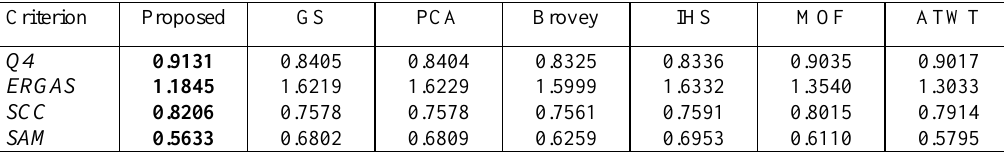
Table 2. Quantitative comparative evaluation results of